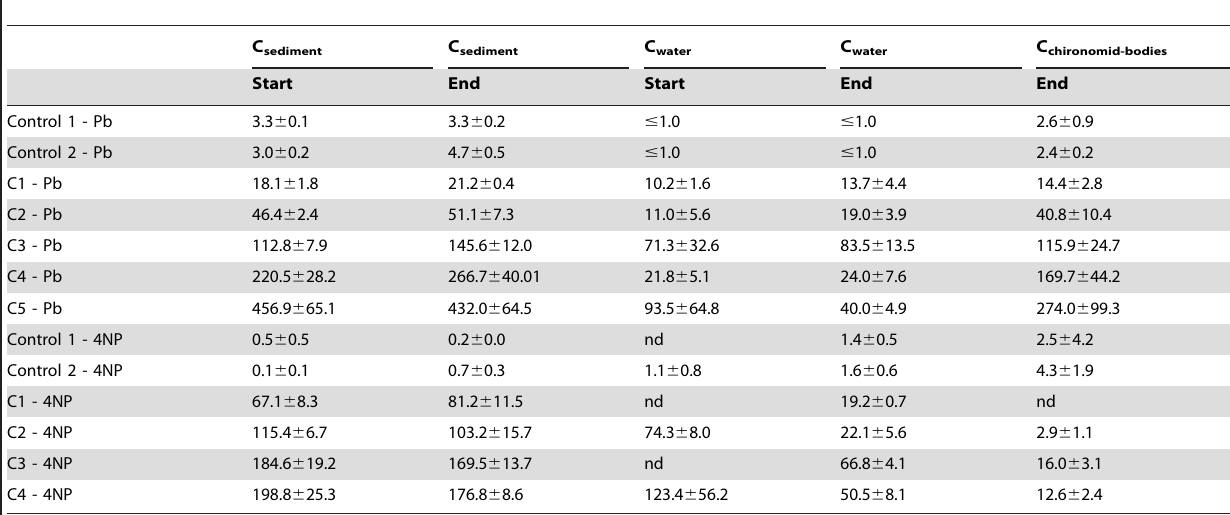
Table 1. Mean concentration in sediment (mg/kg dw.), water column ( m g/l) and chironomid bodies (mg/kg dw.) and standard deviation from the three replicate test aquaria.